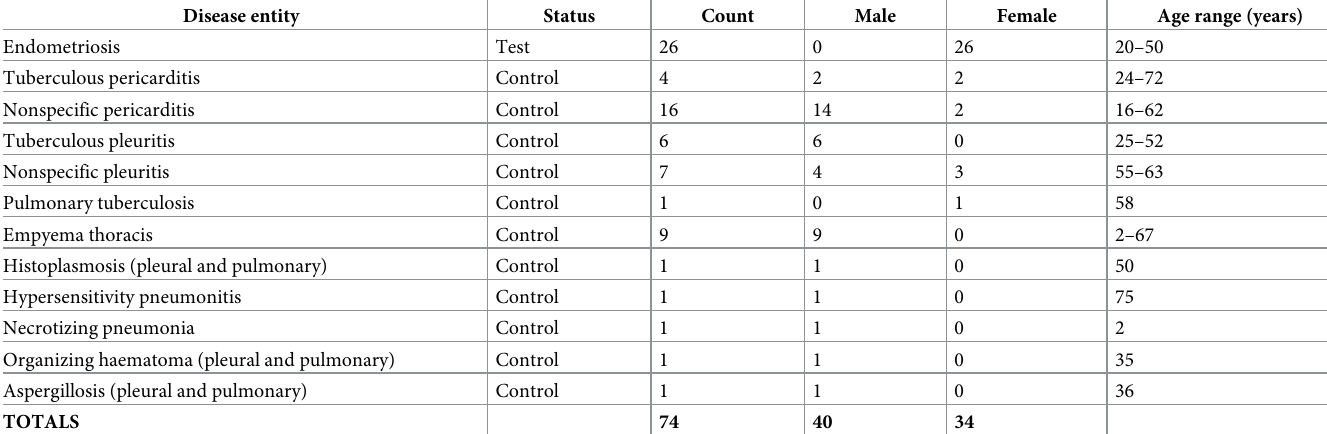
Table 1. Demographic information on all the subjects used in the study.